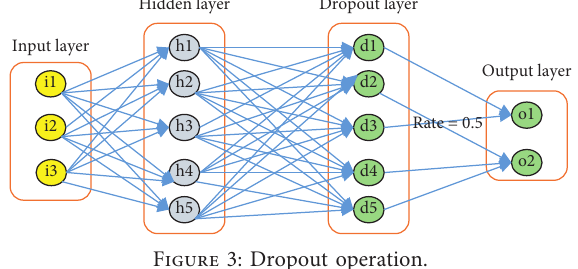
Figure 3: Dropout